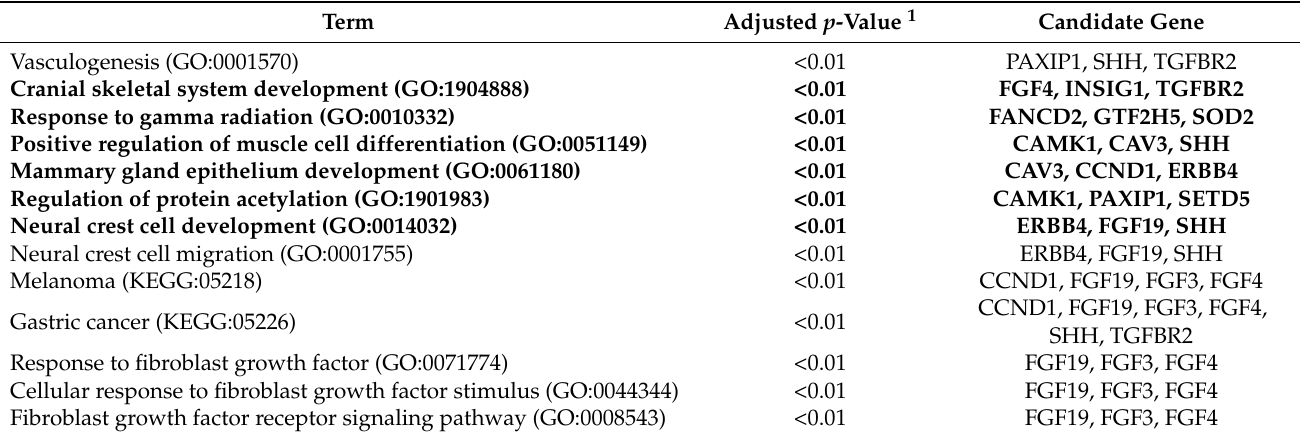
Table 6. Results of GO and KEGG pathway analyses associated with DGE in crossbred